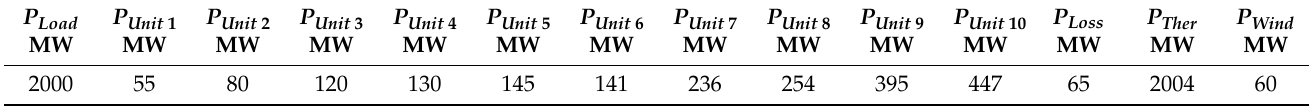
Table 33. Load demand, power generation, and losses of test case 4.